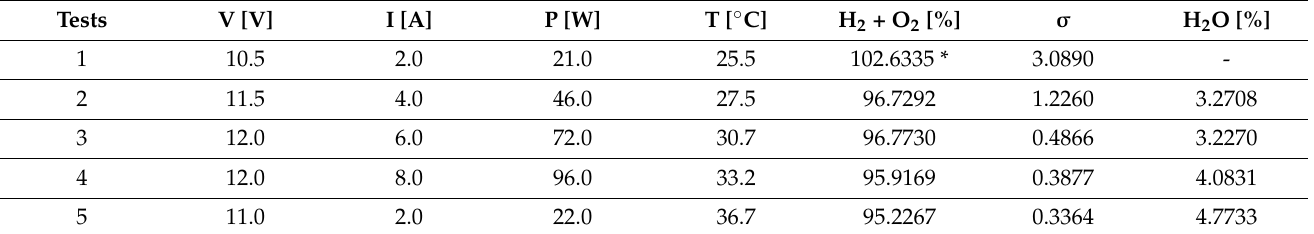
Table 7. Sum of the molar concentration in % of H 2 and O 2 with 20% ( w/w ) of KOH. The percentage of water is estimated from the deficit of the sum of H 2 and O 2